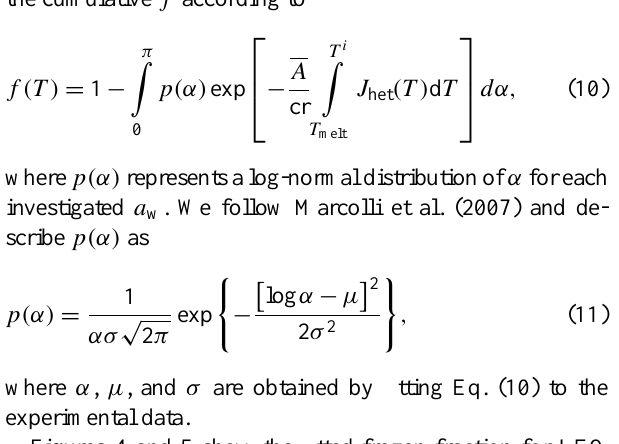
, to calculate f . Blue, het